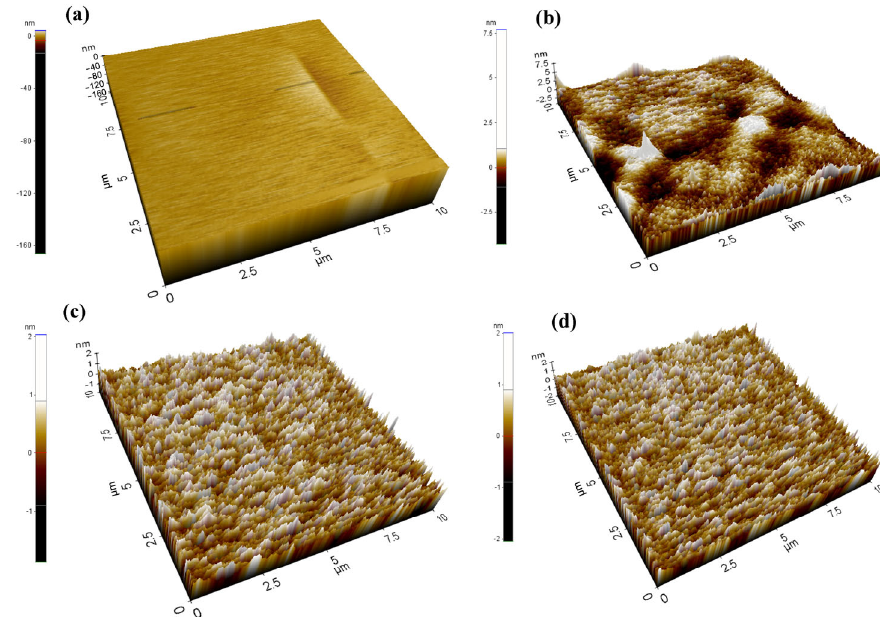
Fig. 2 Atomic force microscope images of the composite surface: (a) SU-8, (b) BN, (c) BNSN, and (d)